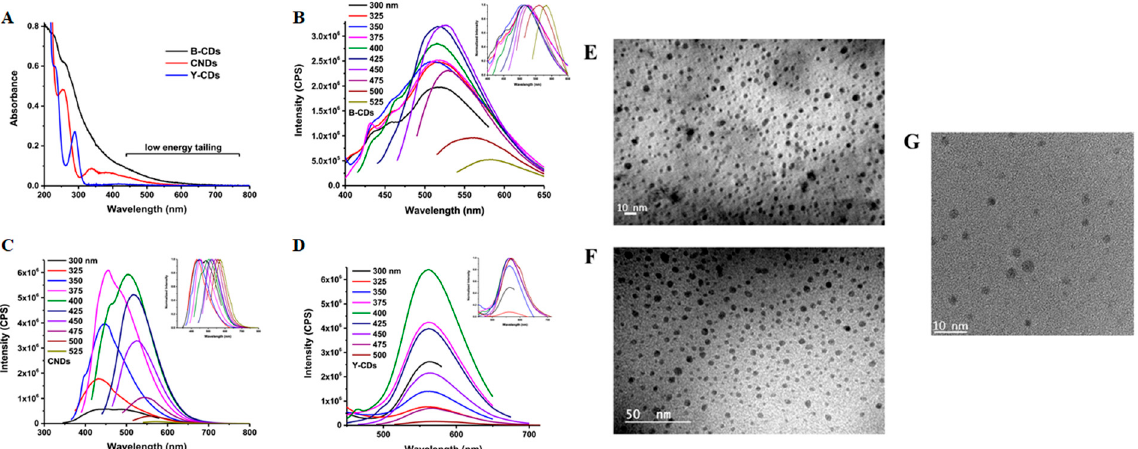
Figure 1. UV-Vis ( A ), fluorescence ( B – D ) and TEM ( E – G ) of three CDs produced from carbon soot (B-CDs), from citric acid and urea (CNDs), and from citric acid and 1,2-diaminebenzene as reported by Mintz [31] . Reprint with all permissions from Elsevier.